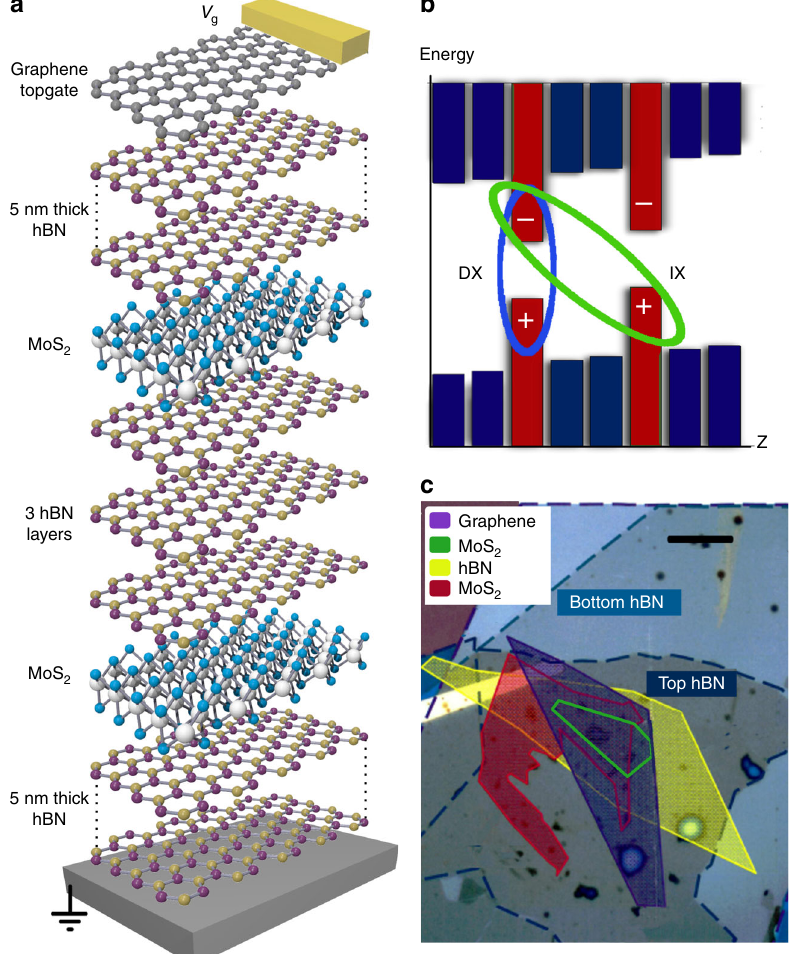
Fig. 1 MoS 2 /hBN coupled quantum well heterostructure. The coupled quantum well van der Waals heterostructure layer ( a ) and energy-band ( b ) diagrams. The ovals indicate a direct exciton (DX) and an indirect exciton (IX) composed of an electron ( − ) and a hole ( + ). ( c ) Microscope image showing the layer pattern of the device, scale bar is 10 μ